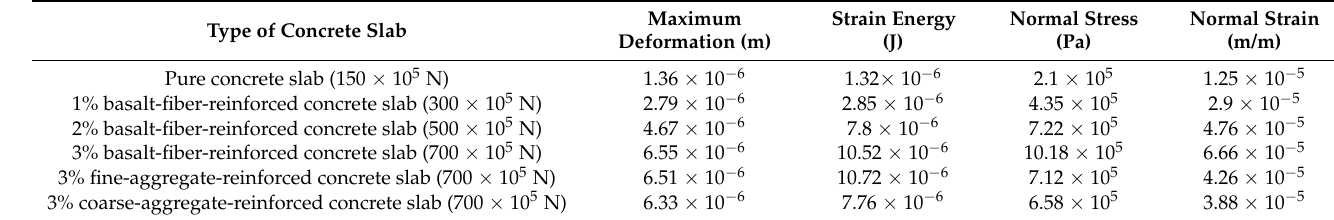
Table 5. Simulation results of mechanical behavior of concrete at tensile failure load (load value obtained from the experiment value of peak load just before